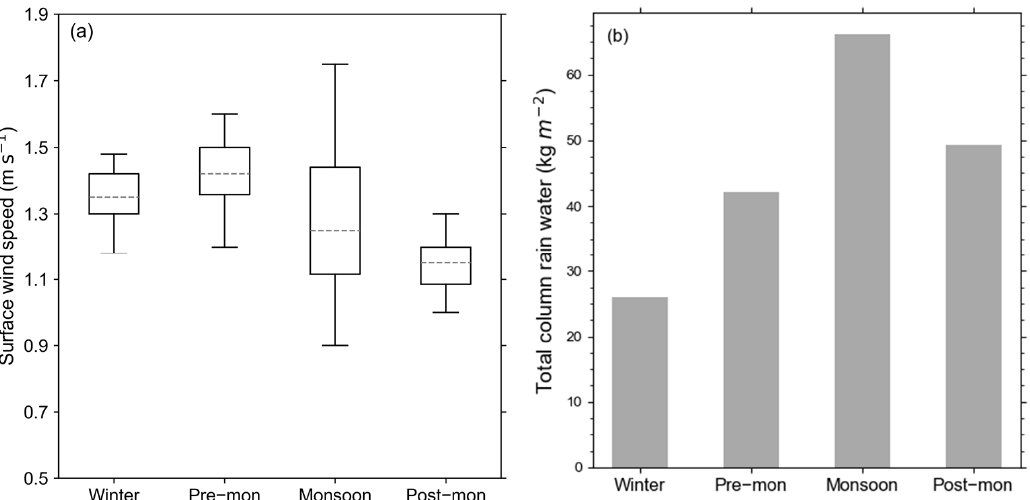
Figure 14. Surface wind speed box diagram ( a ) and the vertical integral of water vapor flux ( b ) in different seasons.